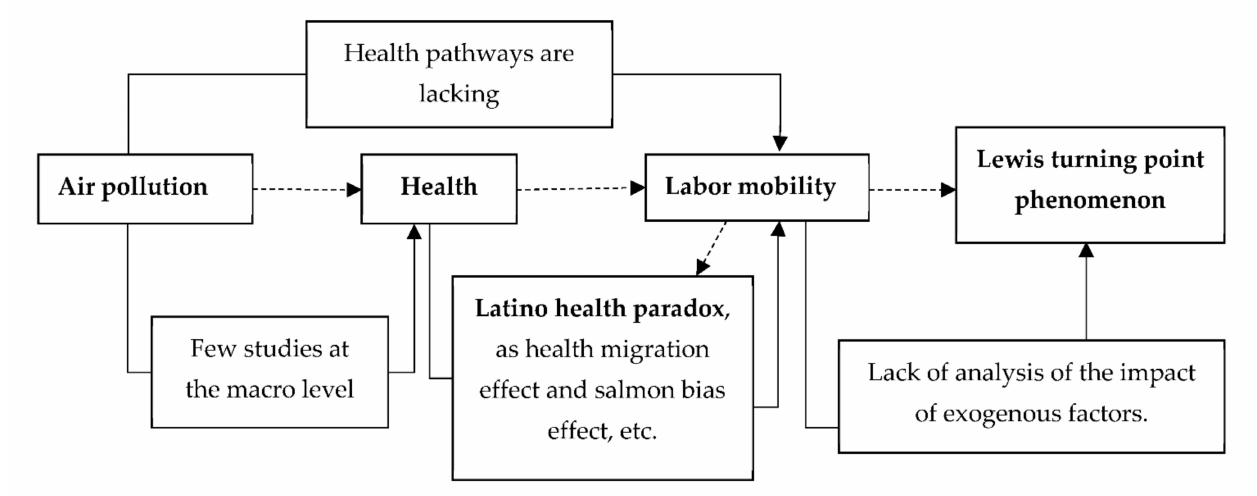
Figure 3. The theoretical